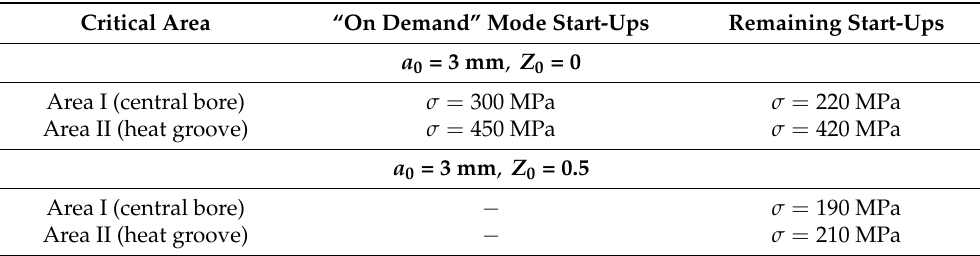
Table 2. Stress values during steam turbine rotor start-up. Critical